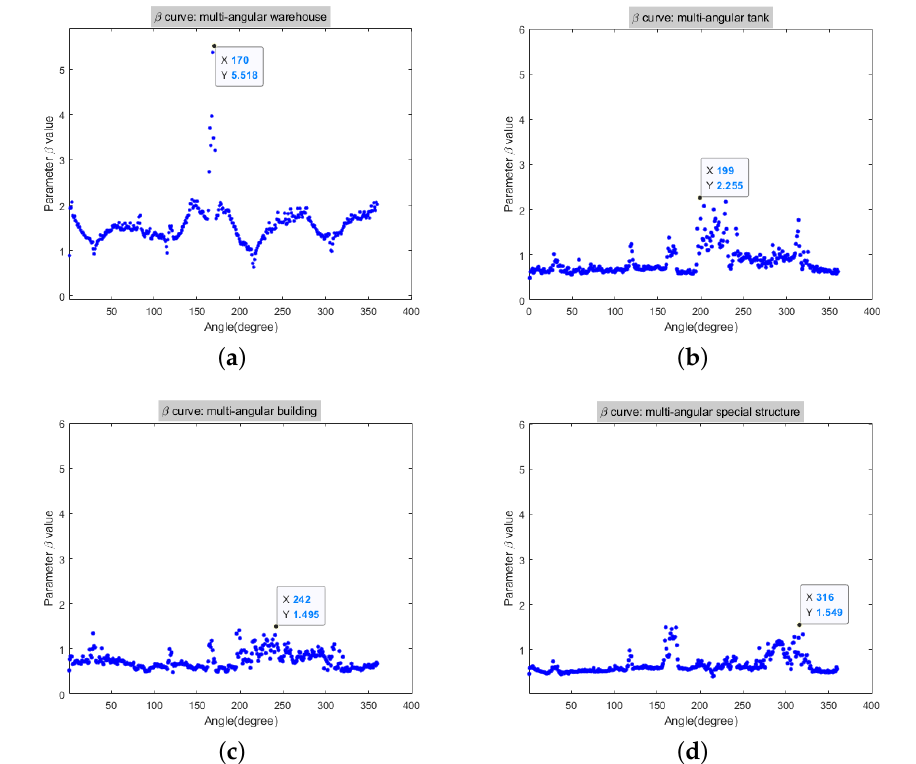
Figure 9. The β parameter values of the four multi-aspect target slices: ( a ) represents β value of multi-aspect warehouse slice; ( b ) represents β value of multi-aspect tank slice; ( c ) represents β value of multi-aspect building slice; ( d ) represents β value of multi-aspect special structure slice.